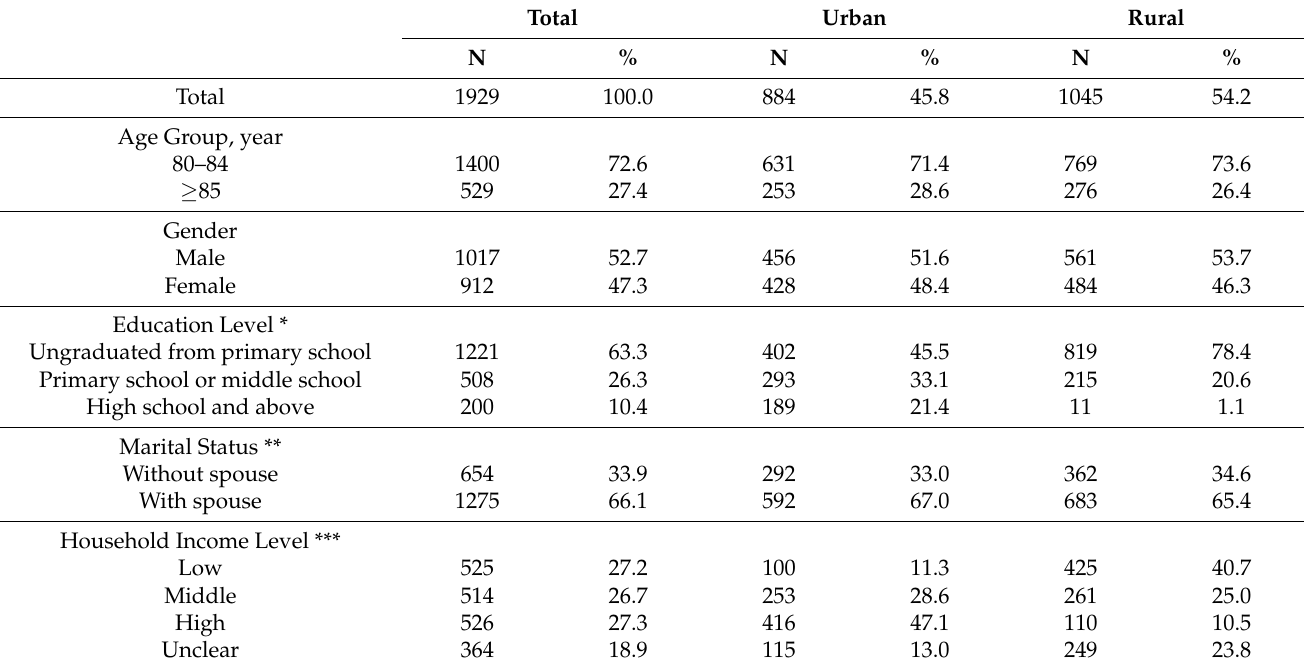
Table 1. Social-demographic distribution of participants aged 80 and above in CACDNS 2015. Total